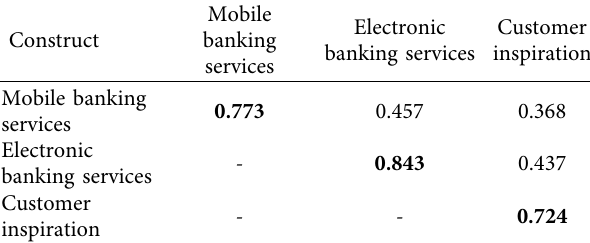
Table 4: Fornell–Larckers